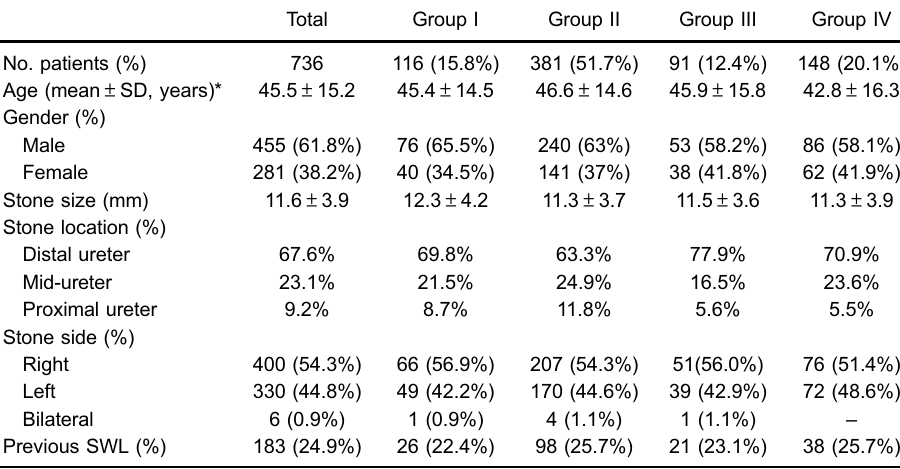
Table 1. Patient demographic data and characteristics of stones.